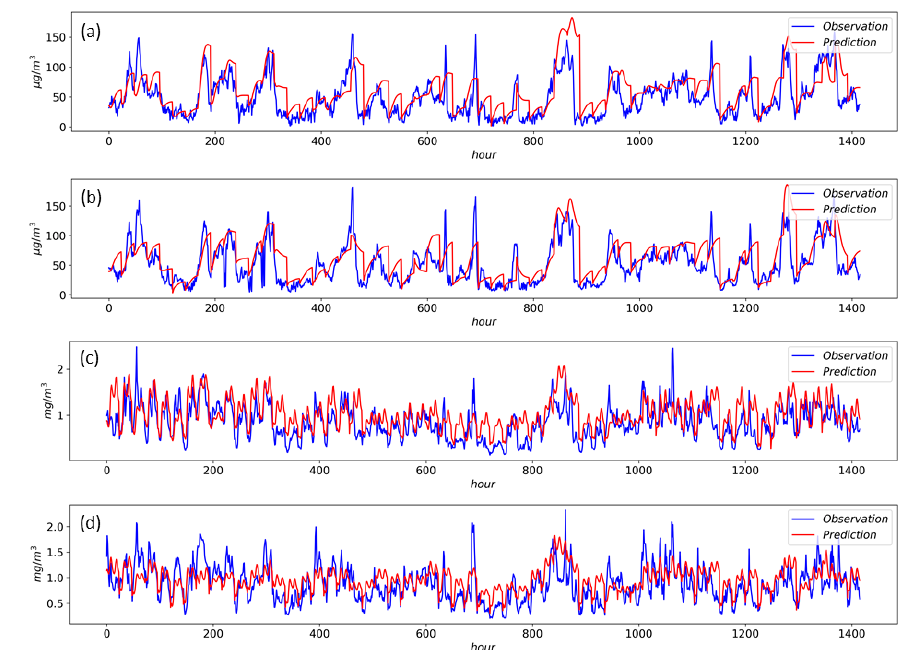
Figure 9. Forecasting results from 1 January to 28 February 2017. ( a ) Xuhui, PM 2.5 ( b ) Jing’an, PM 2.5 ( c ) Xuhui, CO ( d ) Jing’an CO.